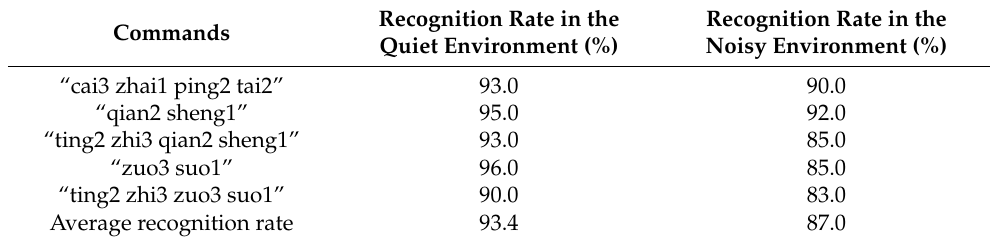
Table 5. Recognition accuracy of the operation voice system in the two